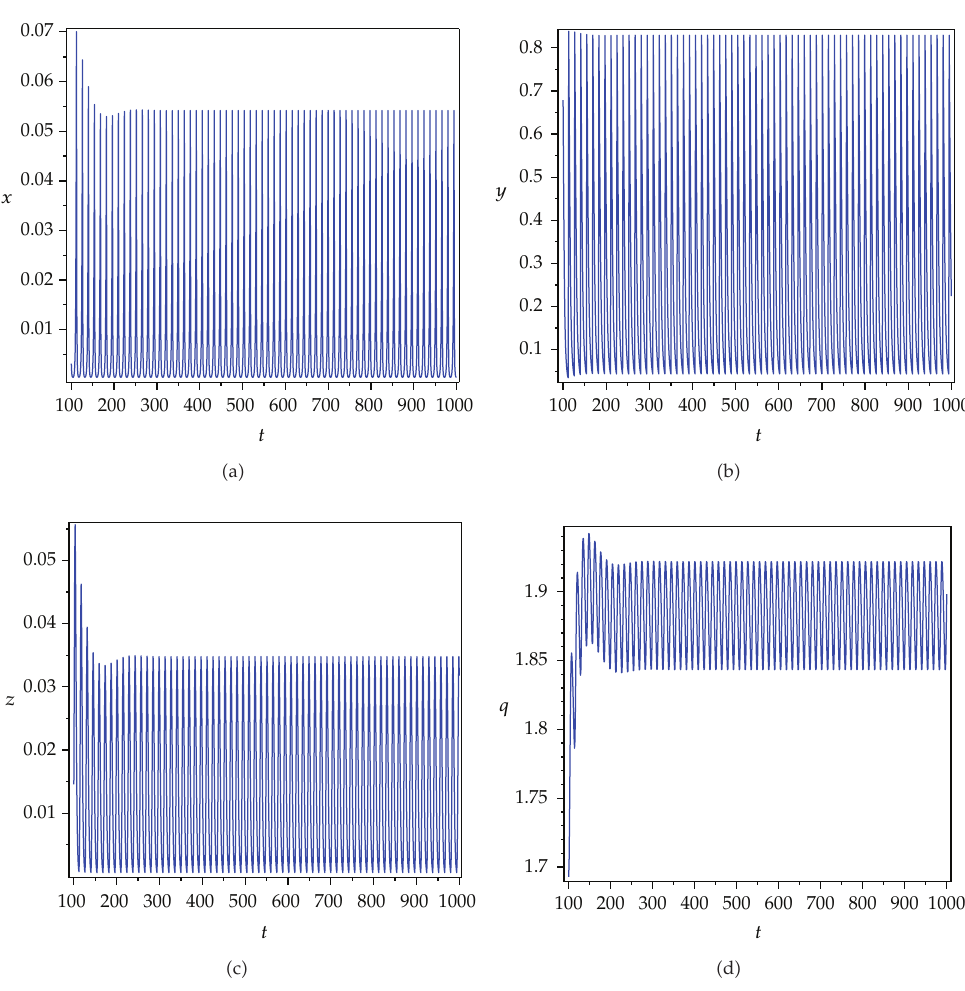
Figure 1: Dynamics of system (cid:2) 1.3 (cid:3) with b (cid:7) 8, d (cid:7) 3, c (cid:7) 3, e (cid:7) 0 . 2, f (cid:7) 3, g (cid:7) 2 . 5, h (cid:7) 0 . 3, m (cid:7) 1 . 2, j (cid:7) 0 . 2, k (cid:7) 0 . 6, l : (cid:7) 0 . 008, a : (cid:7) 3, p (cid:7) 1 . 03, T (cid:7) 14. Time series of (cid:2) a (cid:3) susceptible prey, (cid:2) b (cid:3) infected prey, (cid:2) c (cid:3) the intermediate predator, and (cid:2) d (cid:3) the top